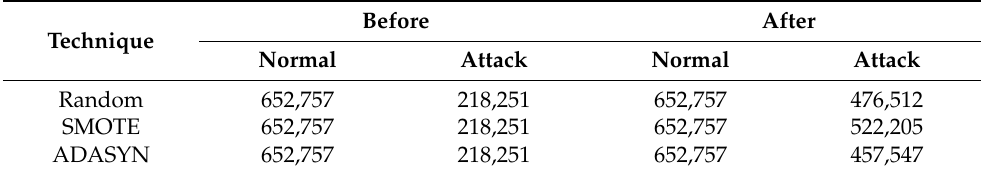
Table 9. Balancing the CICIDS2017 dataset with